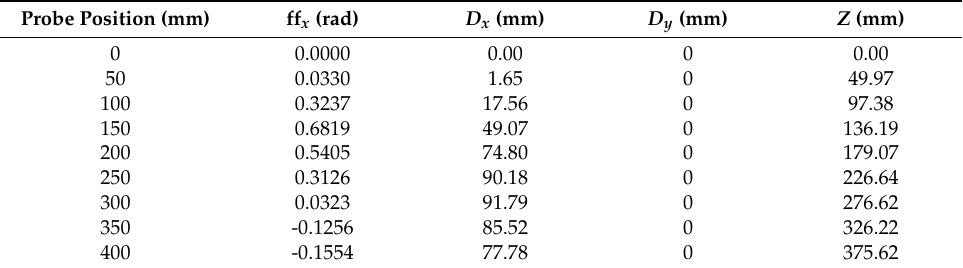
Table 2. Measurement results